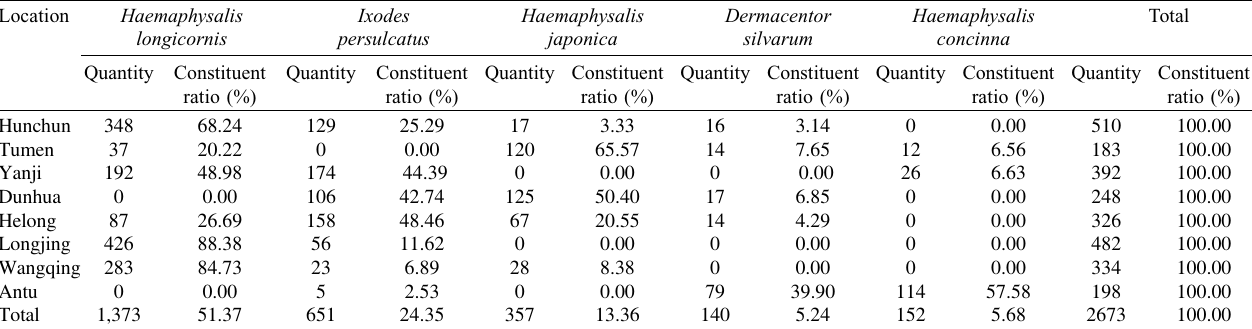
Table 2. Composition of tick species in 8 counties and cities of